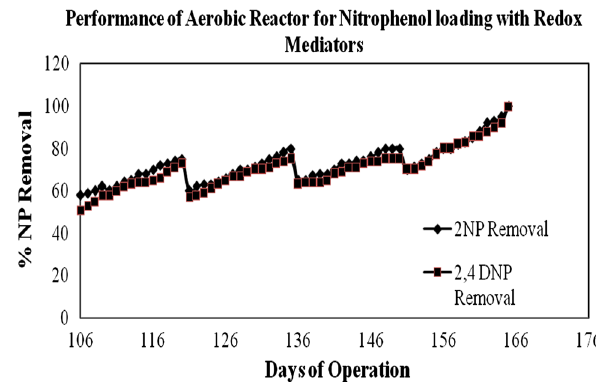
Fig. 10 Nitrophenol removal of aerobic reactors with redox mediators